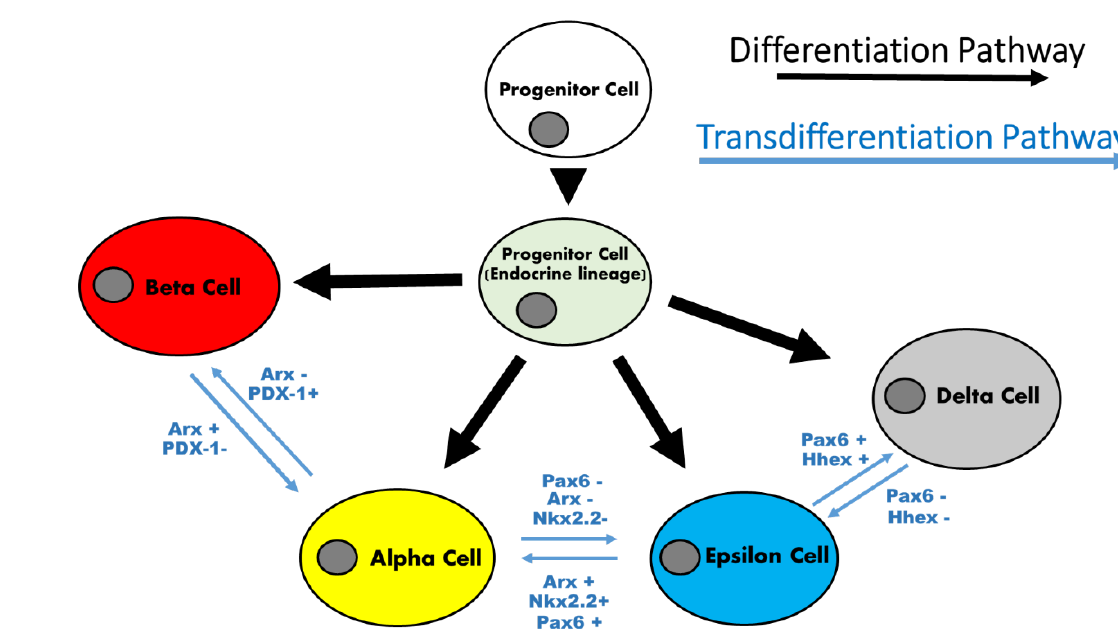
Figure 2. Pancreatic endocrine cell identity markers and possible cell trans/differentiation pathways after SG/RYGB. Pancreatic endocrine-cell identity markers and possible cell differentiation pathways from progenitor-cells (Black arrows) or trans-differentiation from other pancreatic endocrine-cells (Blue arrows) after sleeve gastrectomy or roux-en-Y gastric bypass.